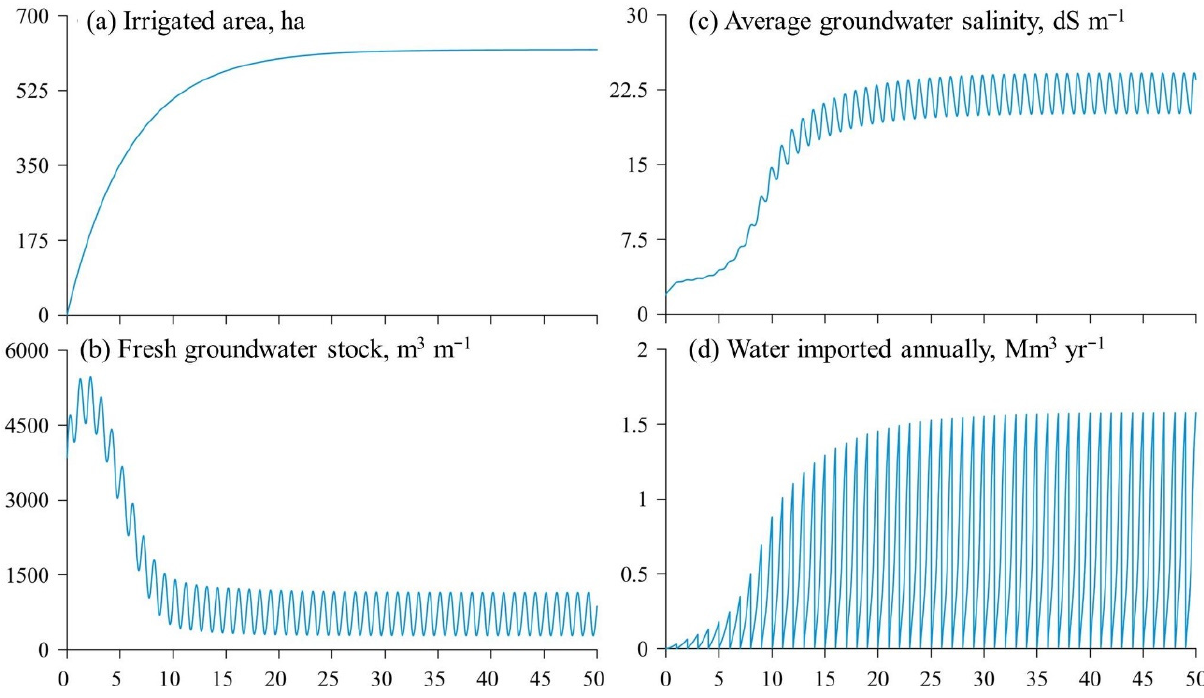
Figure 3. Time trajectories under the default scenario of ( a ) irrigated area, ( b ) fresh groundwater, ( c ) groundwater salinity and ( d ) water imported annually to the GSB.